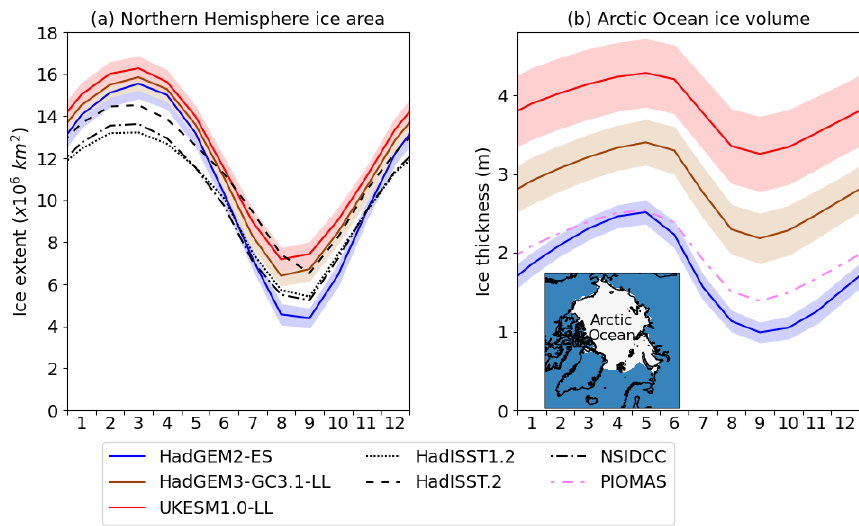
Figure 1. (a) 1980–1999 average sea ice extent for the whole Northern Hemisphere for the evaluated models and reference datasets (HadISST1.2, HadISST.2 and NSIDC); (b) 1980–1999 average sea ice volume over the Arctic Ocean region shown in the subpanel for the evaluated models and PIOMAS. For each model, ensemble mean (lines) and twice the standard deviation (shading) is